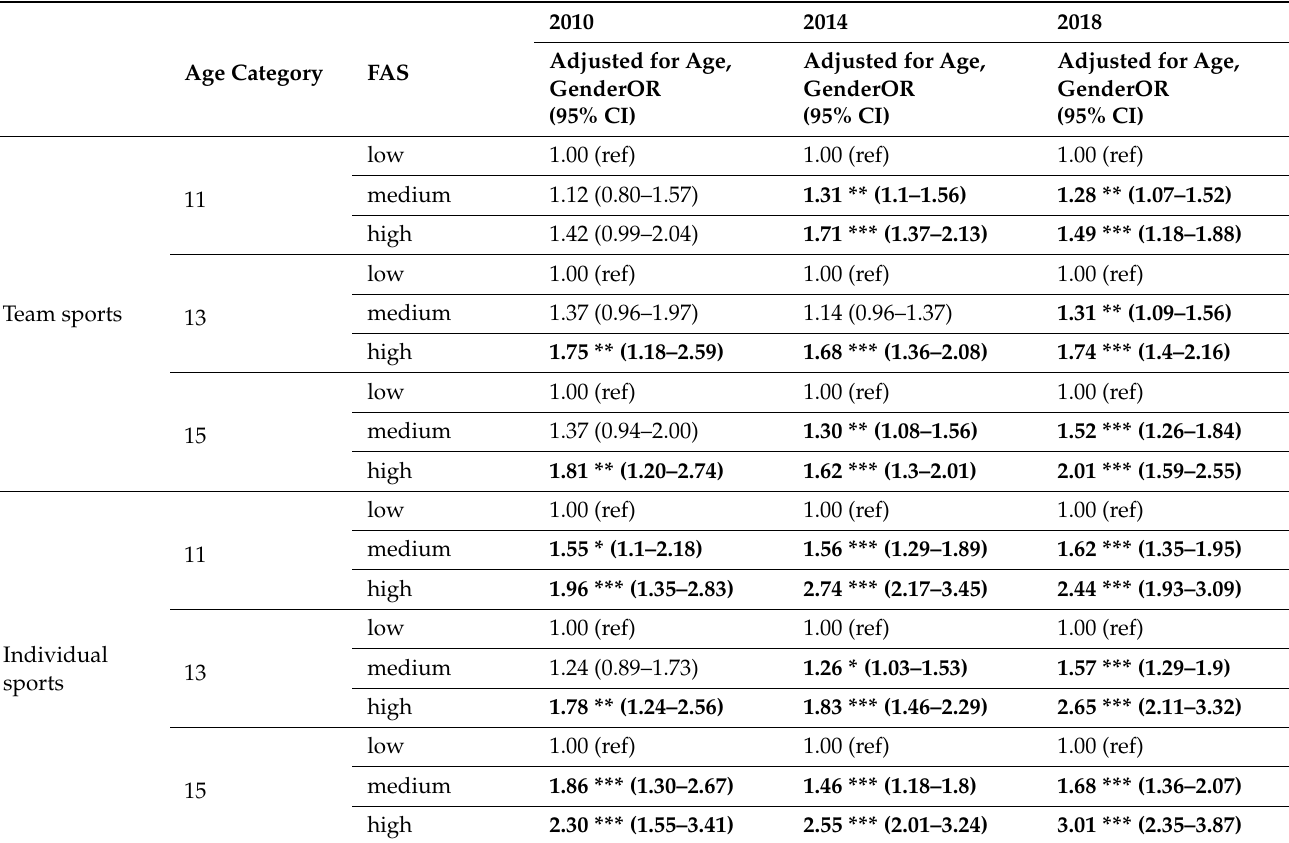
Table 3. Odd ratios—sample divided into 3 age categories adjusted for age and